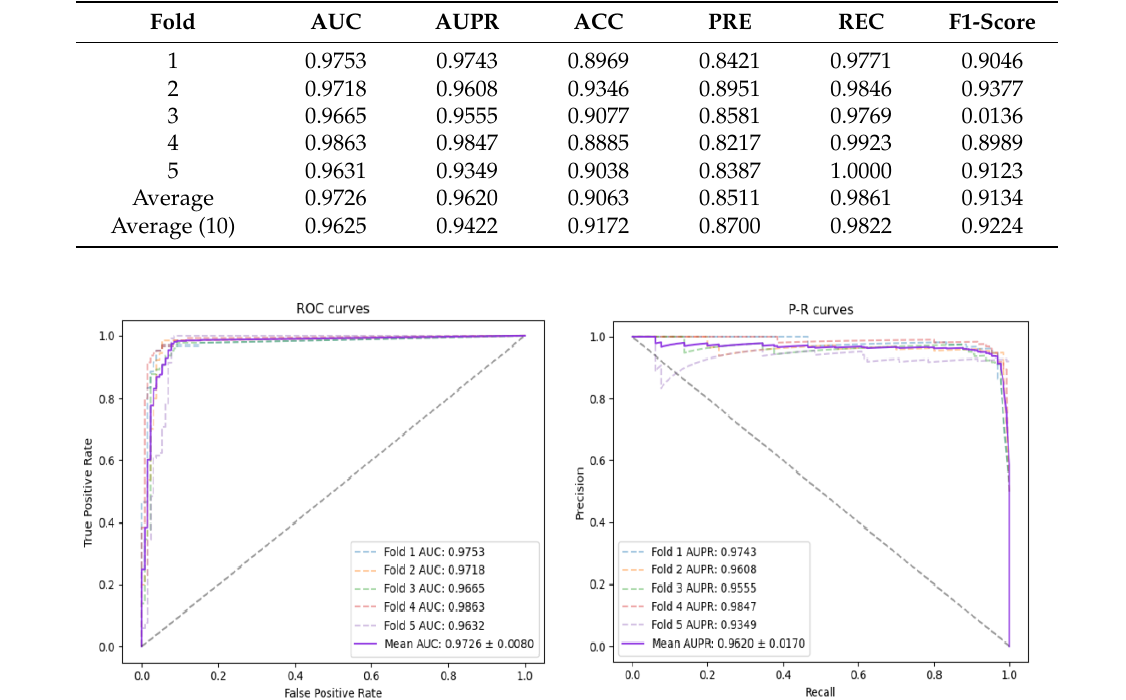
Table 2. Results of FFCV on CircR2Disease achieved by GGCDA.